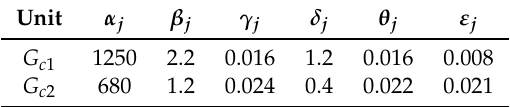
Table A2. The operation cost function parameters of CHP units.